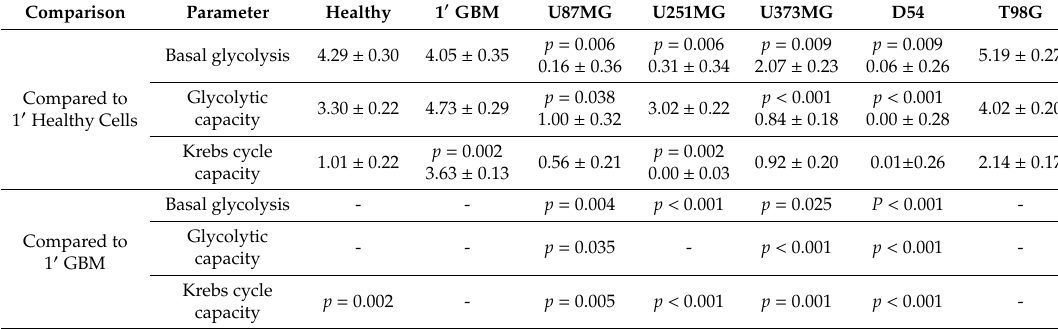
Table 2. Values of significance for cell comparisons of Extracellular Acidification Rate (ECAR)-related metabolic parameters.